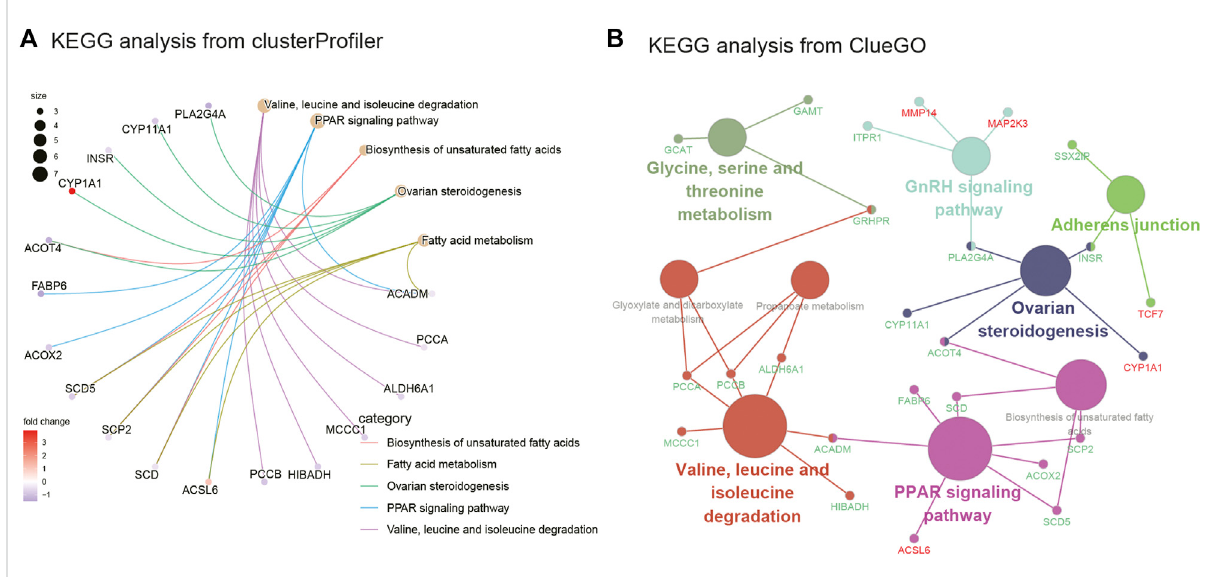
FIGURE 4 KEGG enrichment analysis and KEGG analysis from ClueGO. (A) KEGG analysis of DEGs from clusterpro fi ler. (B) KEGG analysis of DEGs from ClueGO (version: v.2.5.8).